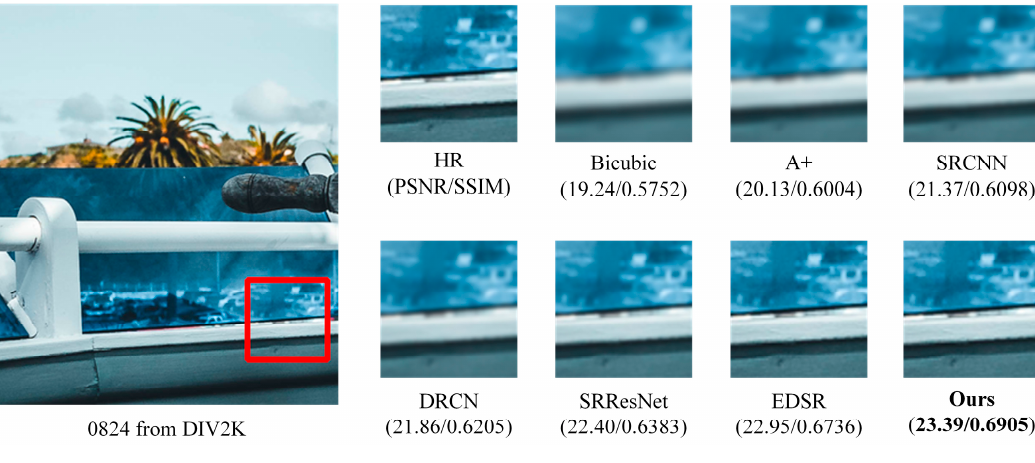
Figure 5. The results of “Image0824” (DIV2K) on × 4 super-resolution. MRSR shows a better performance in the qualitative comparison with other methods.